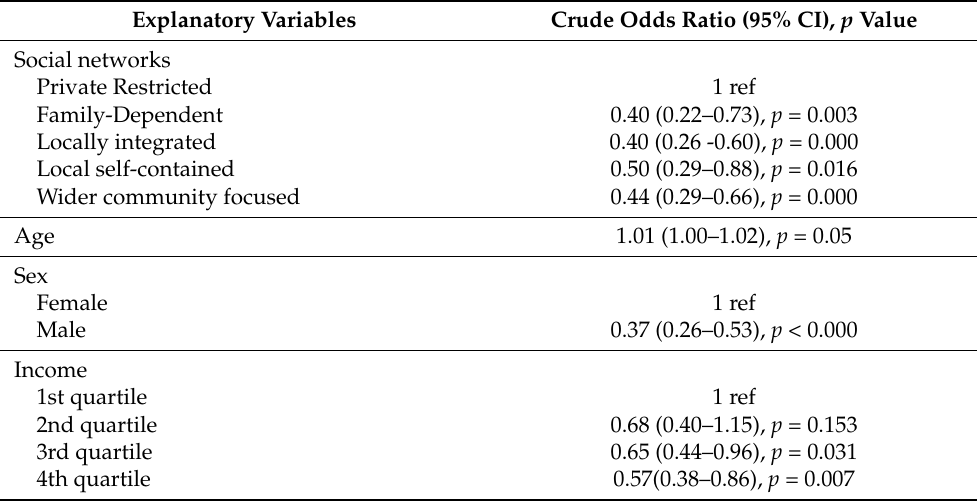
Table 3. Association between social network types and